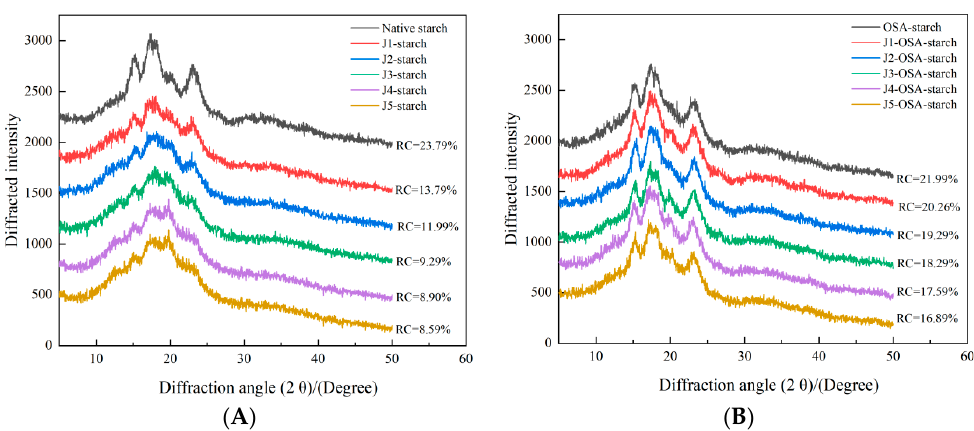
Figure 2. XRD patterns of J-starch and J-OSA-starch: ( A ), XRD patterns of J-starch; ( B ), XRD patterns of J-OSA-starch.